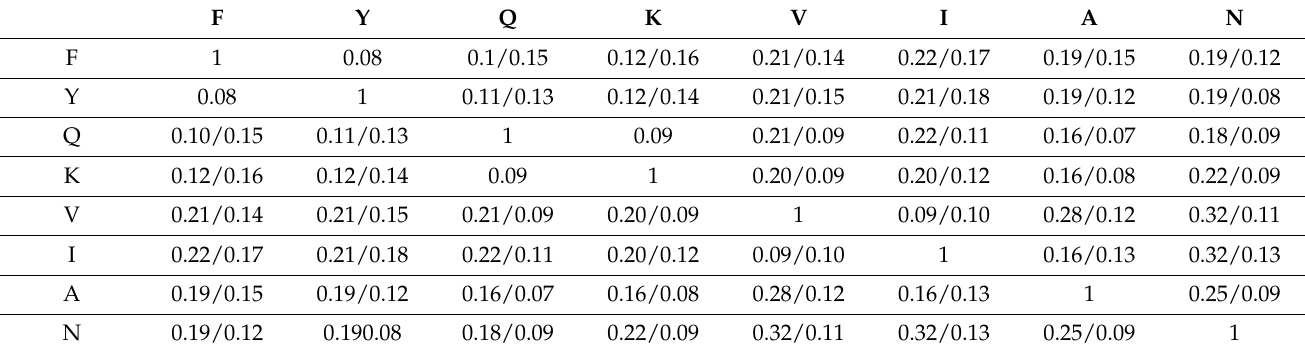
Table 1. List of Hellinger distances between the indicated amino acid residues independent of neighbors (left value) and in the presence of a glutamine residue at the upstream position (right value). Hellinger distance values indicating at least moderately different distributions are typed in bold. All values were taken from Ting et al. [19] and divided by